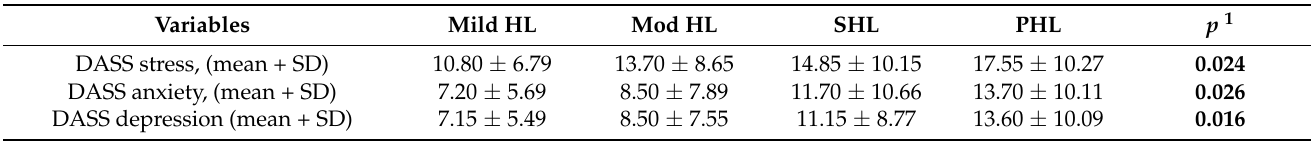
Table 2. Differences in the severity of the symptoms of stress, anxiety and depression in groups with different degrees of hearing